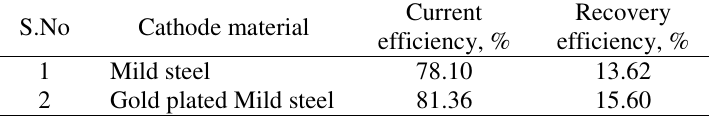
Table 3. Effect of cathode material on current and recovery